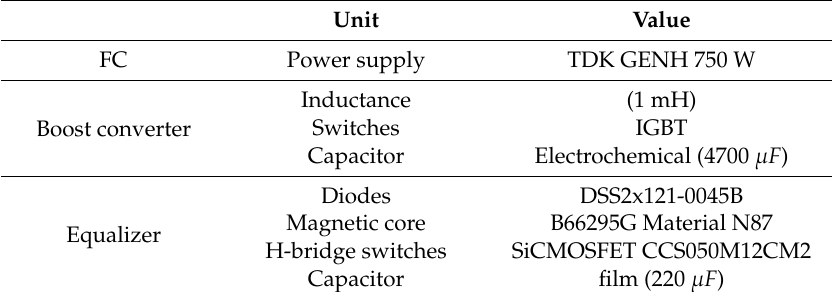
Figure 12. Test bench of the proposed system. Table 2. Parameters of the used devices in the test